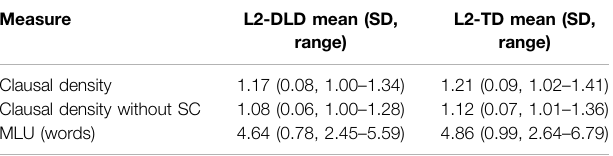
TABLE 5 | Clausal density and MLU by